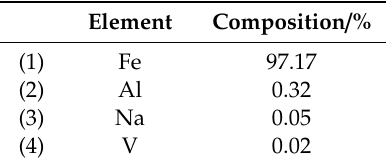
Table 2. ICP-MS analysis of hematite